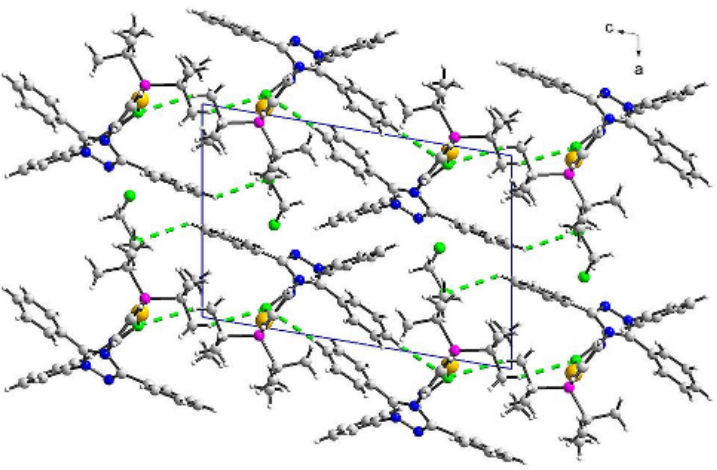
Figure 3. The crystal network viewed along b axis for ( 2 ). C-H…Cl hydrogen bonds marked by dotted green lines show bc layers.